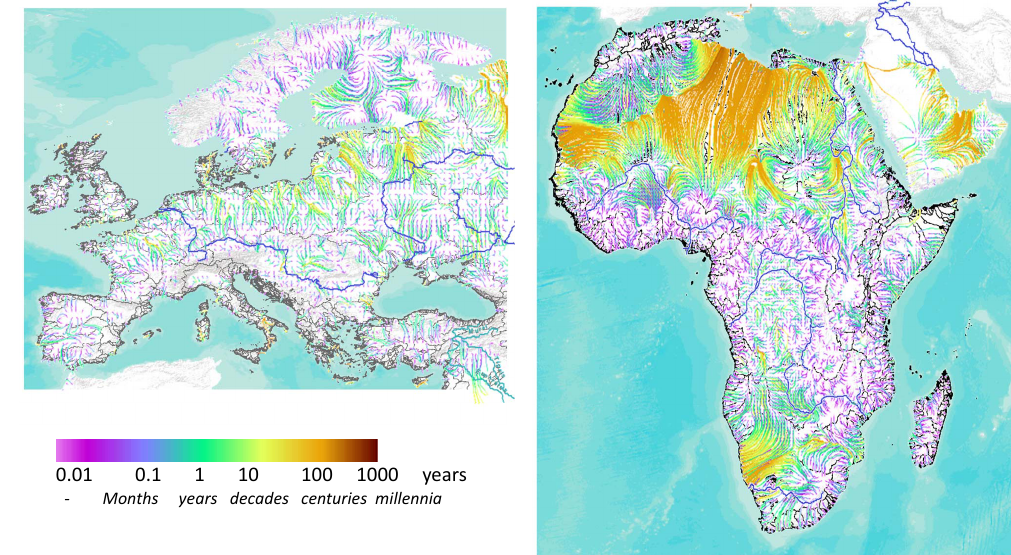
Figure 9. Flow paths simulated for NW Europe and Africa, underlain by river basin boundaries, overlain with major rivers.